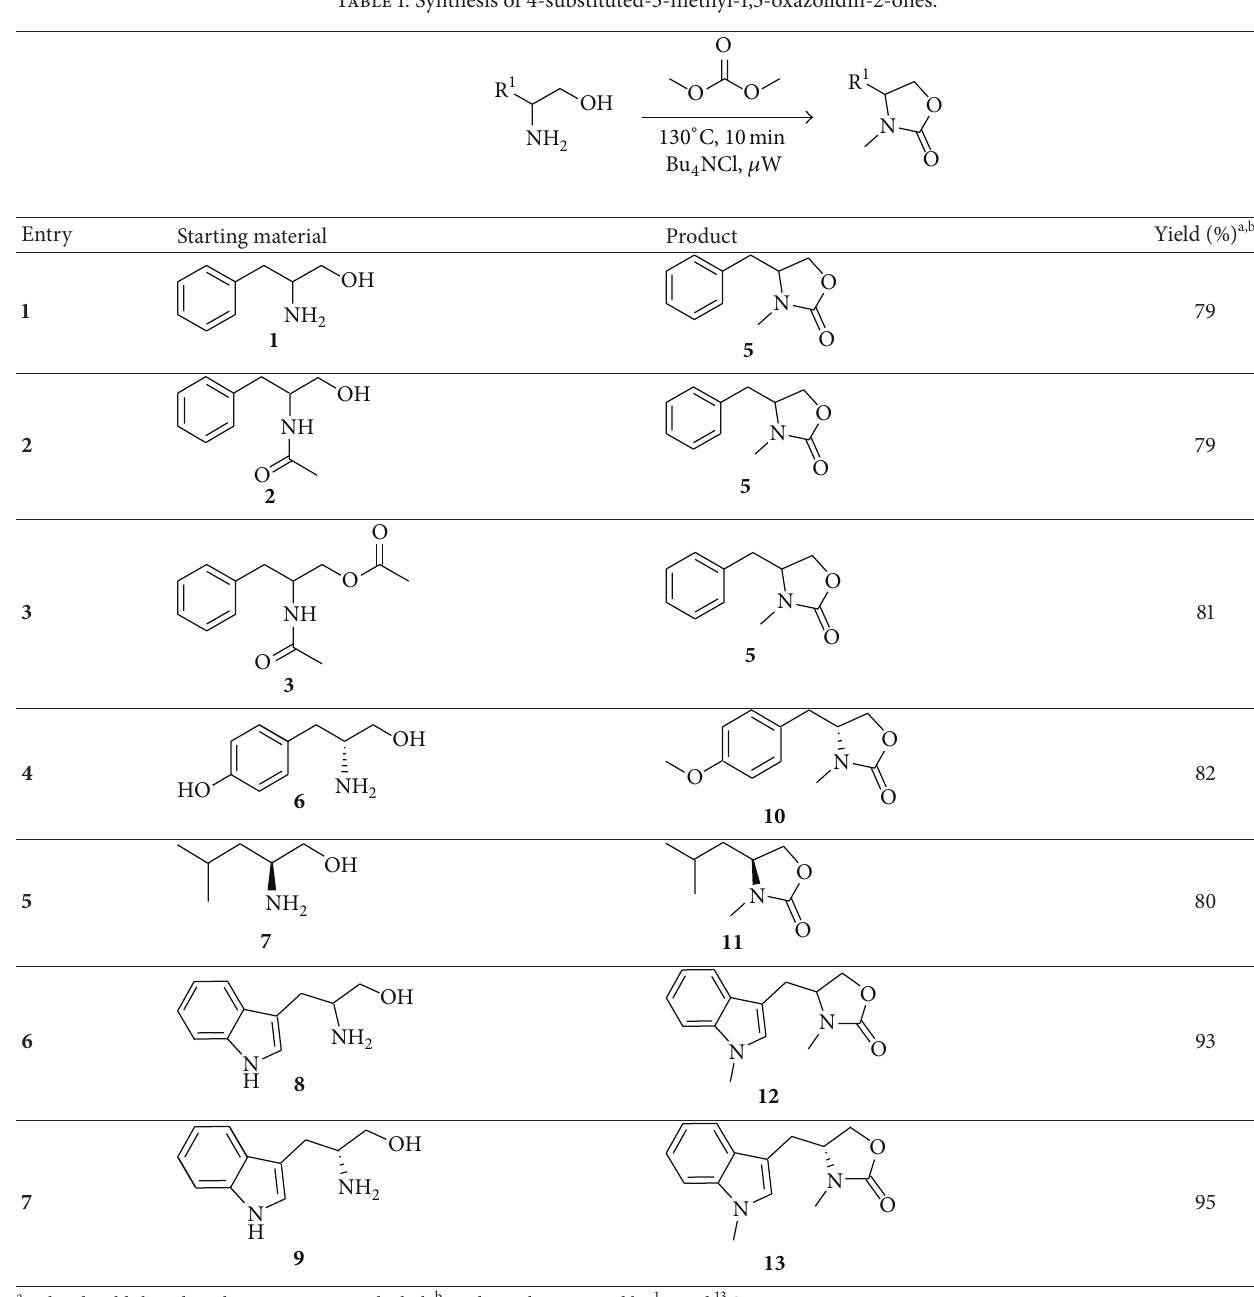
Table 1: Synthesis of